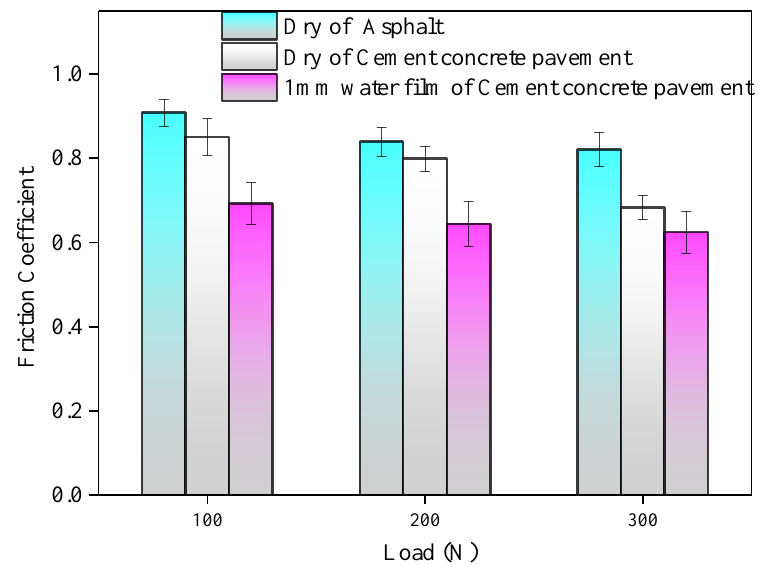
Figure 15. The variation of coefficient with load.